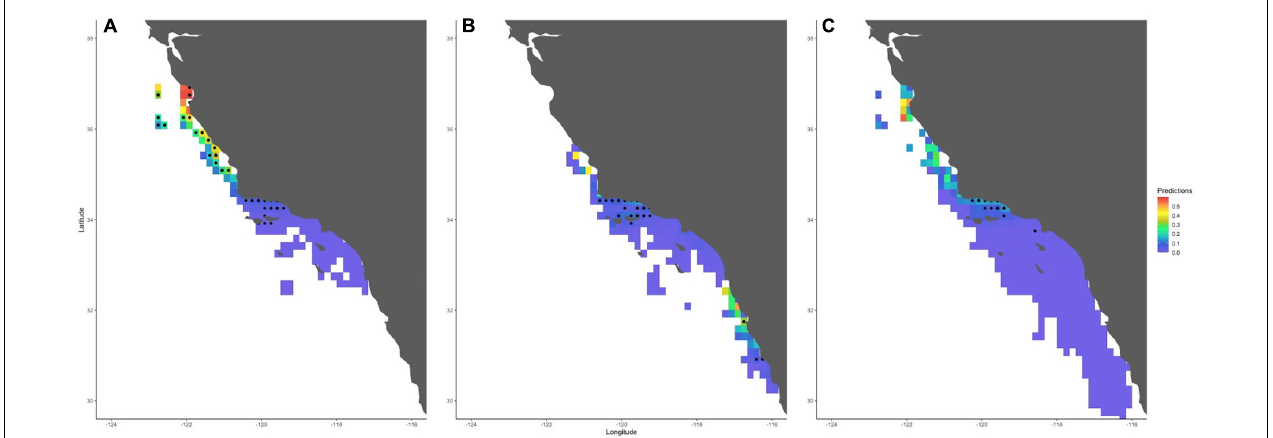
FIGURE 5 | Maps of the western United States and Mexico extending from San Francisco (top of map) to Baja California (bottom of map), showing predicted shark sightings probability from our best-fit model (Model 1) for each decade for which there were presences throughout the systematic survey period ( A–C : 1960s, 1970s, 1980s). Black dots represent basking shark presences recorded during the systematic surveys. White represents areas for which there is no model prediction. Maps from Models 2 and 3 can be found in the Supplementary Materials